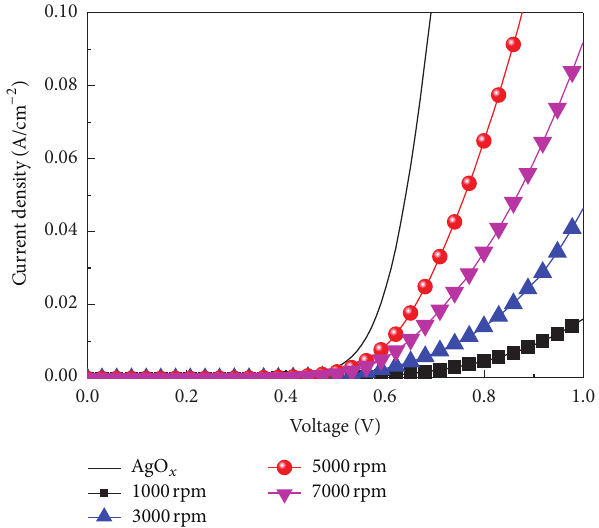
Figure 5: 𝐽 - 𝑉 characteristics of TOPVs under darkness.